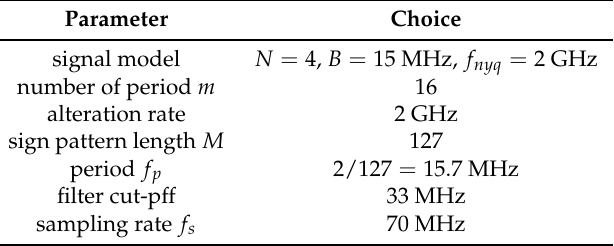
Table 1. Prototype specifications.